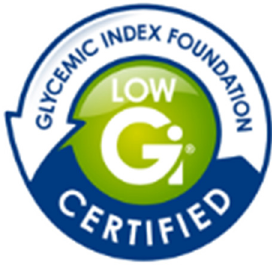
Figure 1. Australia and New Zealand’s Glycaemic Index (GI) Symbol.